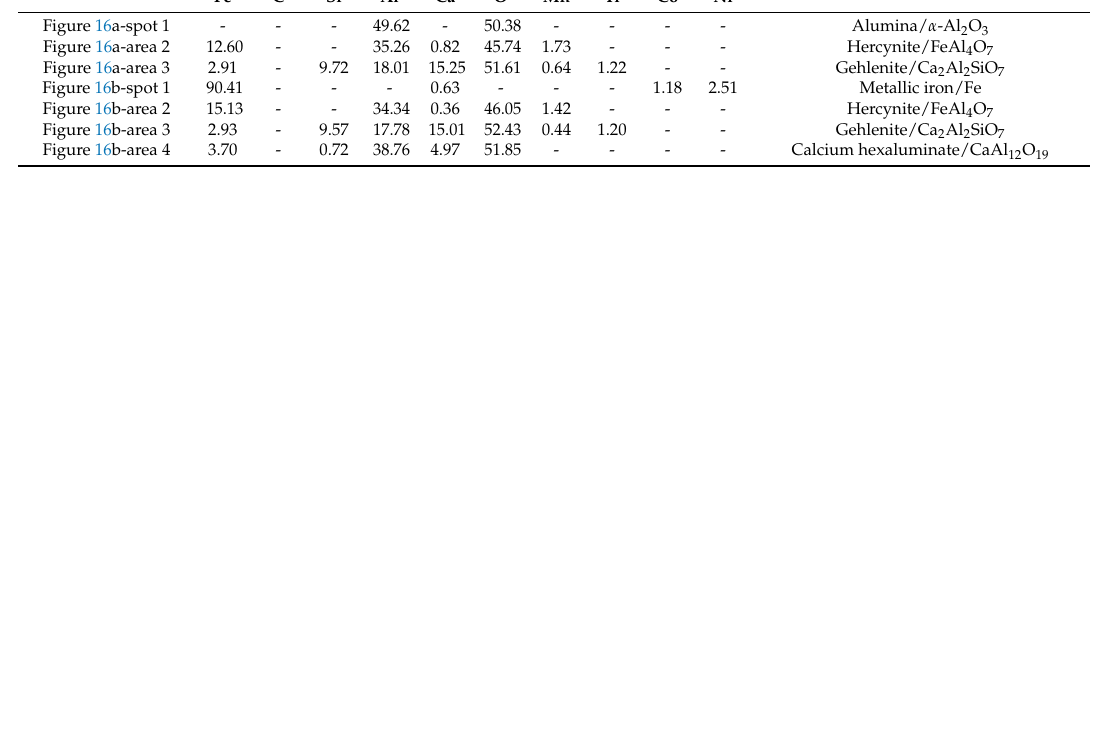
Table 4. EDS results of the alumina slag obtained at the optimal